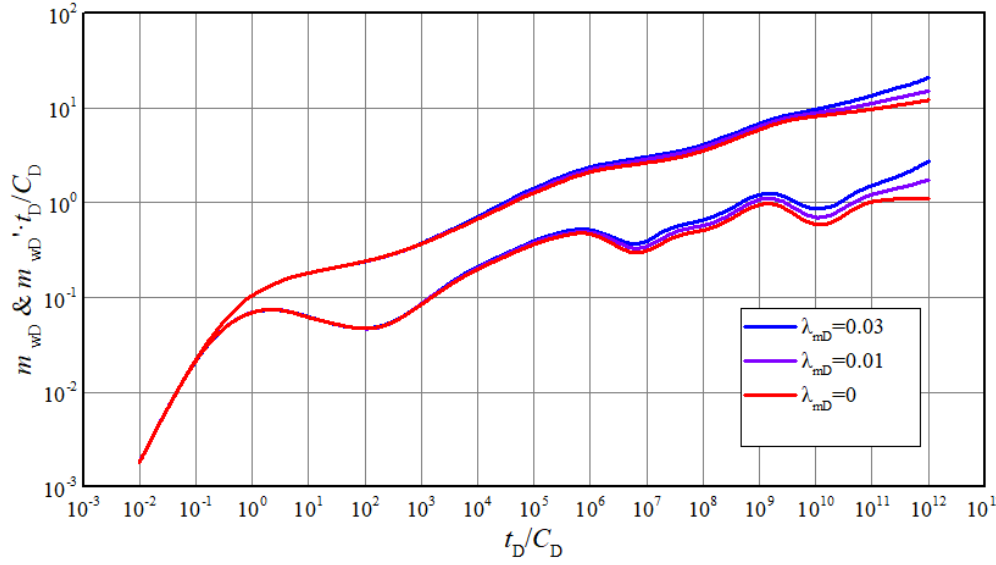
Figure 5. The e ff ect of threshold pressure gradient on transient pseudo-pressure and derivative curves.